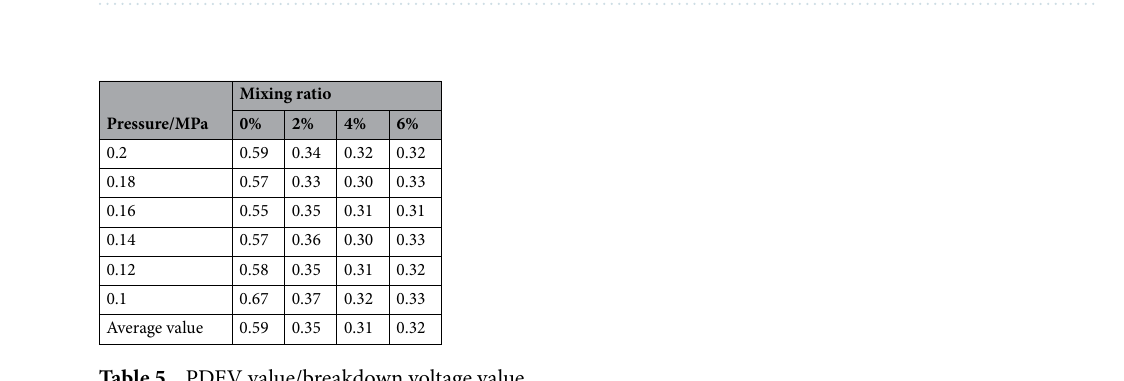
Table 4. PDIV value/breakdown voltage value.